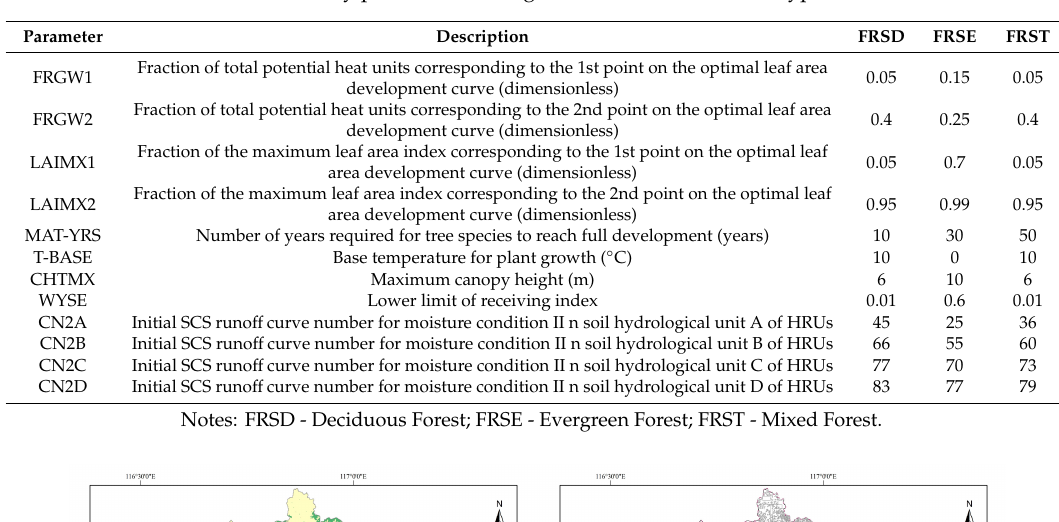
Table 3. Key parameter settings for di ff erent forestland types.